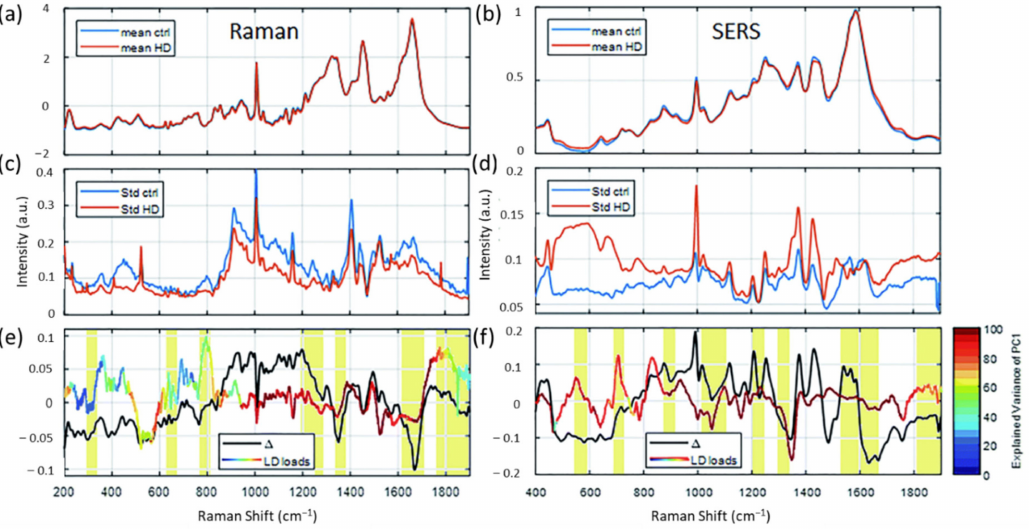
Figure 5. Illustration of applicability of Raman techniques in diagnosis of HD. Average RS ( a ) and SERS ( b ) spectra of serum from healthy control subjects (blue lines) and HD patients (red line) as well as their standard deviations (( c , d ), respectively). The different spectra of the averages for RS (black line, ( e )) and SERS (black line, ( f )) are within the standard deviation ( c , d ) of the average spectra ( a , b ). Yellow marked regions indicate important peaks. Adapted with permission from Reference